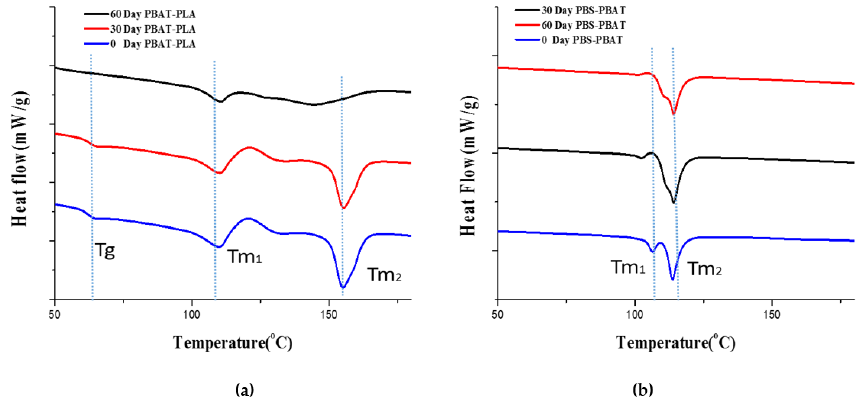
Figure 4. ( a ) The second heating scans of the PBAT–PLA samples before, during and after degradation, ( b ) and of the PBAT–PBS samples before, during and after degradation. Table 4. DSC results for the PBAT–PLA and PBAT–PBS blends, as well as pure PLA, PBAT and